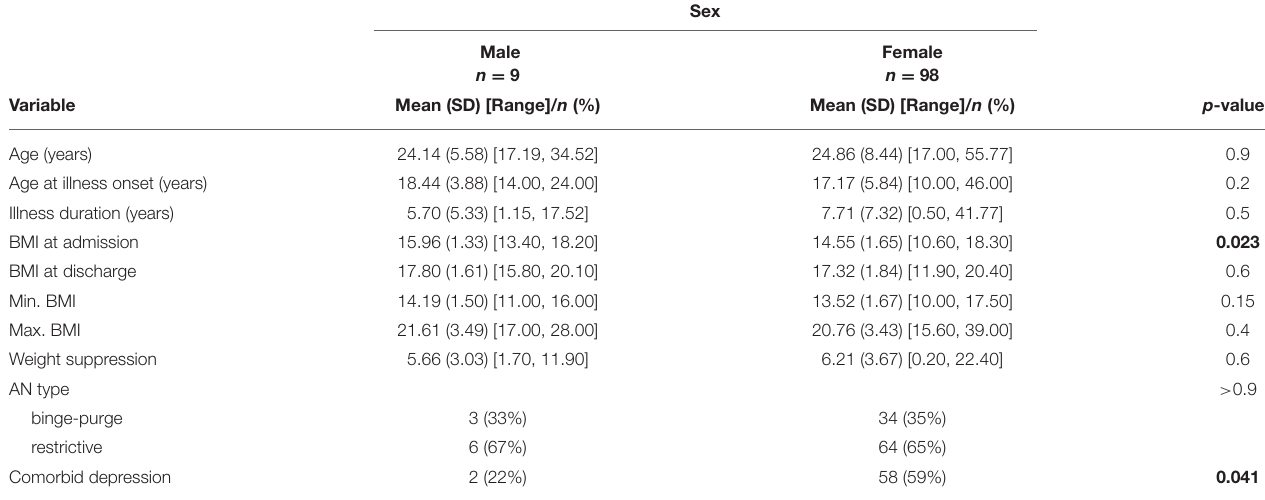
TABLE 1 | Demographic and weight characteristics.